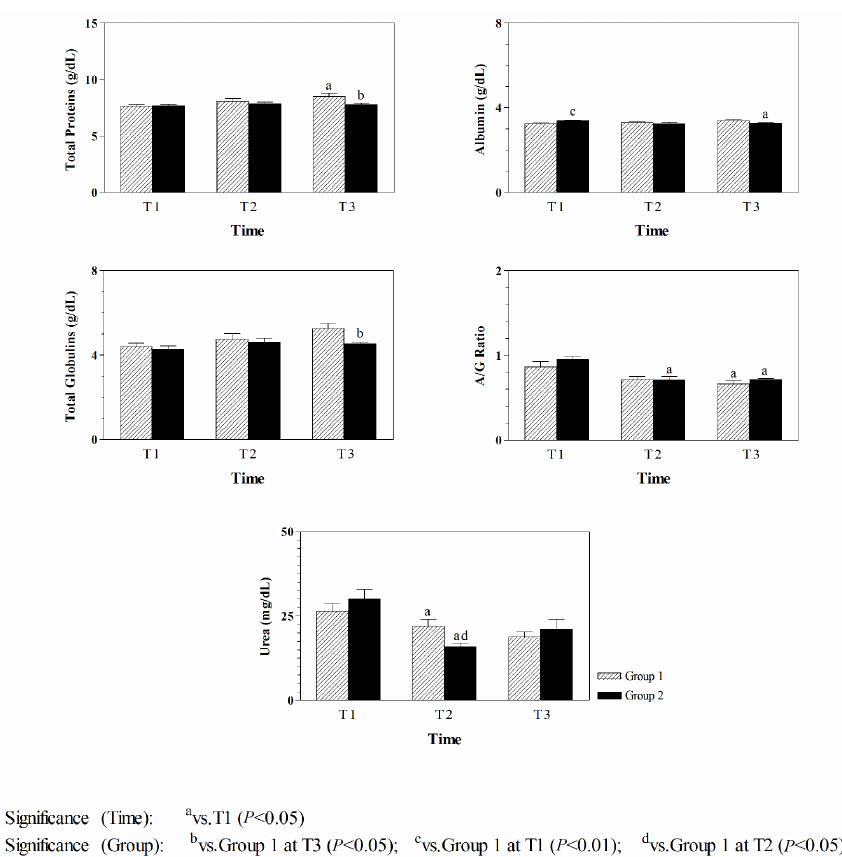
Figure 1. Pattern of total proteins, albumin, globulins, A/G ratio, and urea in Group 1 and Group 2 dairy cows monitored at 1 week before the expected partum (T1), and at 1 week (T2) and 2 weeks (T3)